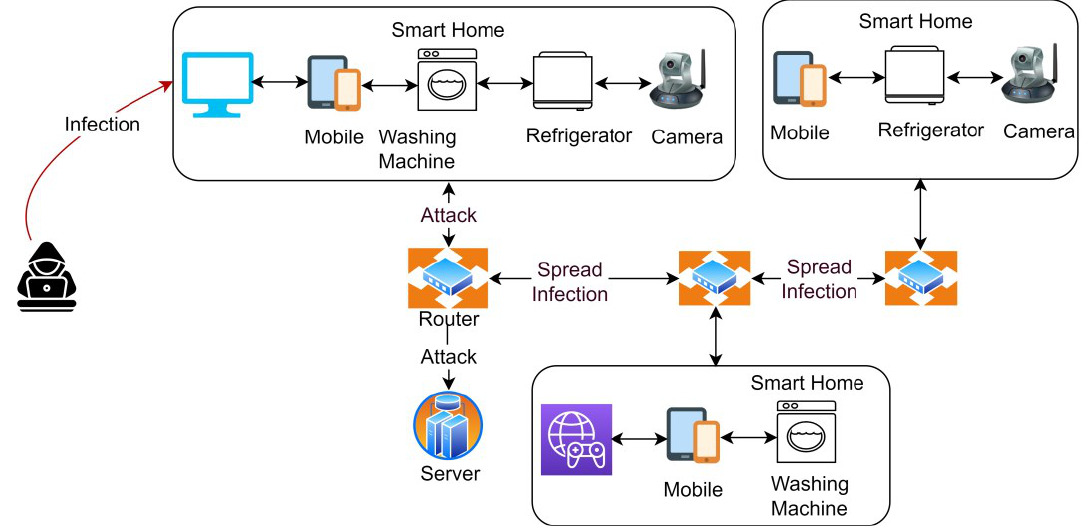
Figure 2. Attack Scenario .